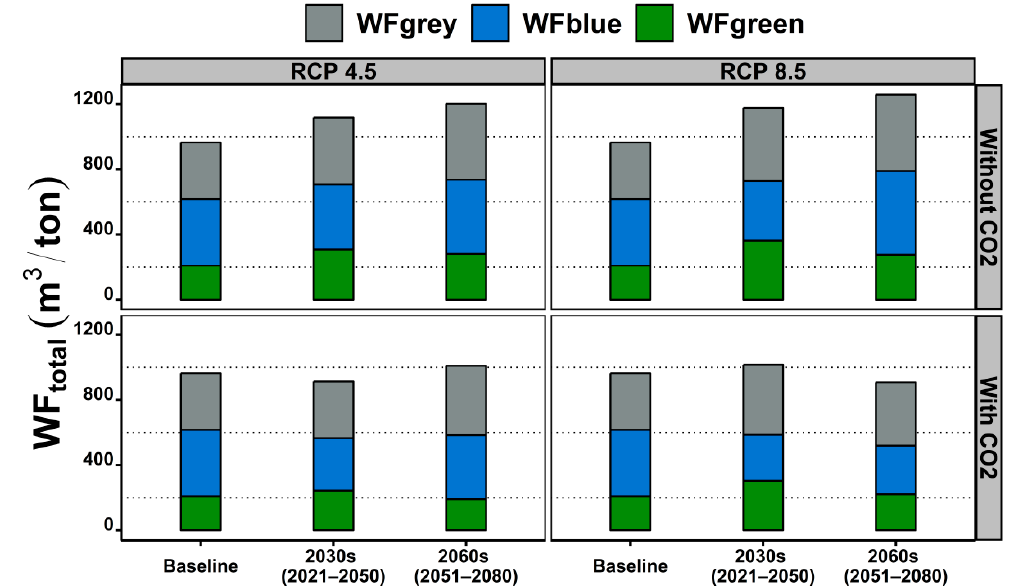
Figure 11. Composition of wheat total water footprints (WF total ) in terms of grey (WF grey ), blue (WF blue ), and green water footprints (WF green ) during the baseline and future time slices.